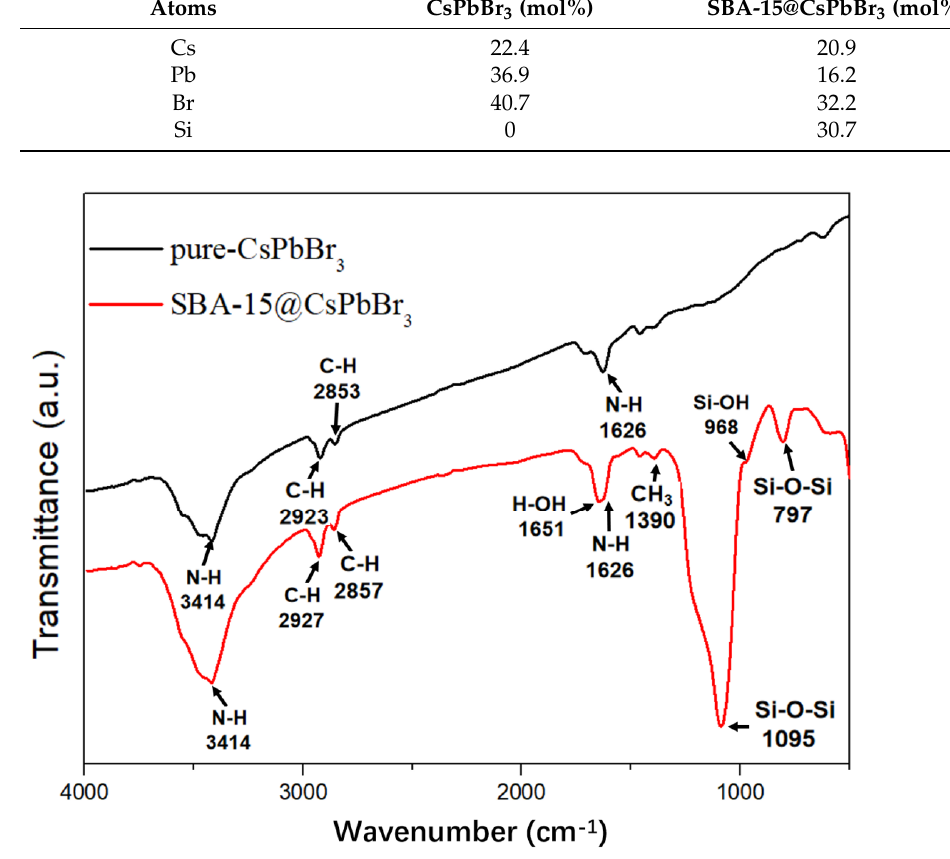
Figure 4. FTIR of (black) CsPbBr 3 QDs and (red) SBA-15@CsPbBr 3 QDs. The XRD images of pure CsPbBr 3 QDs and SBA-15@CsPbBr 3 QDs were shown in Figure 5. The black curve of pure CsPbBr 3 QDs showed strong diffraction peaks at 15.19°, 21.55°, 30.65°, 34.37°, 37.77° and 43.89°, corresponding to cubic CsPbBr 3 (PDF#00-054-0752) (100), (110), (200), (210), (211) and (220) planes, respectively. Comparing to the two